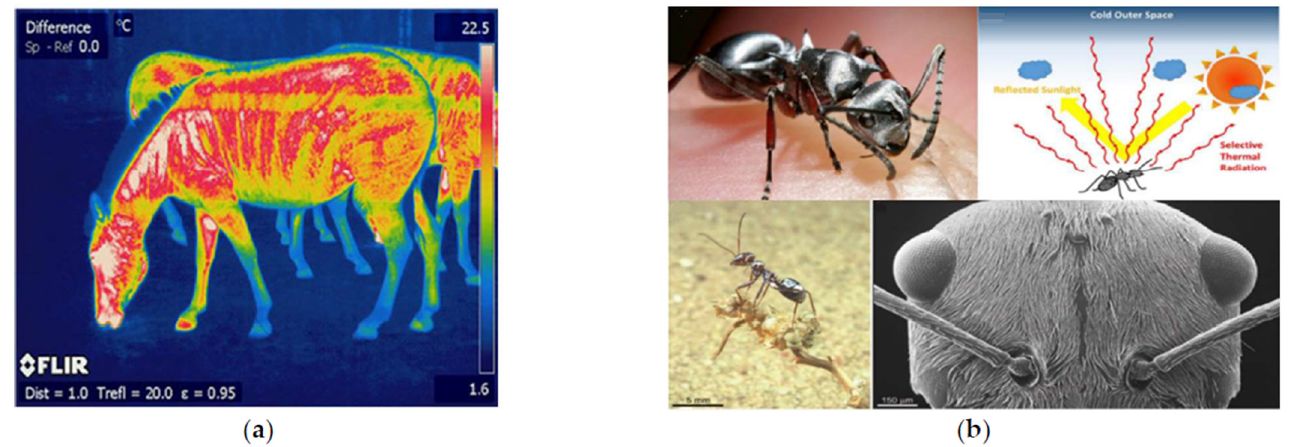
Figure 7. Convective currents due to temperature variation in the black and white lines ( a ). Infrared photo with their respective surface temperature variations ( b ) [18–20].